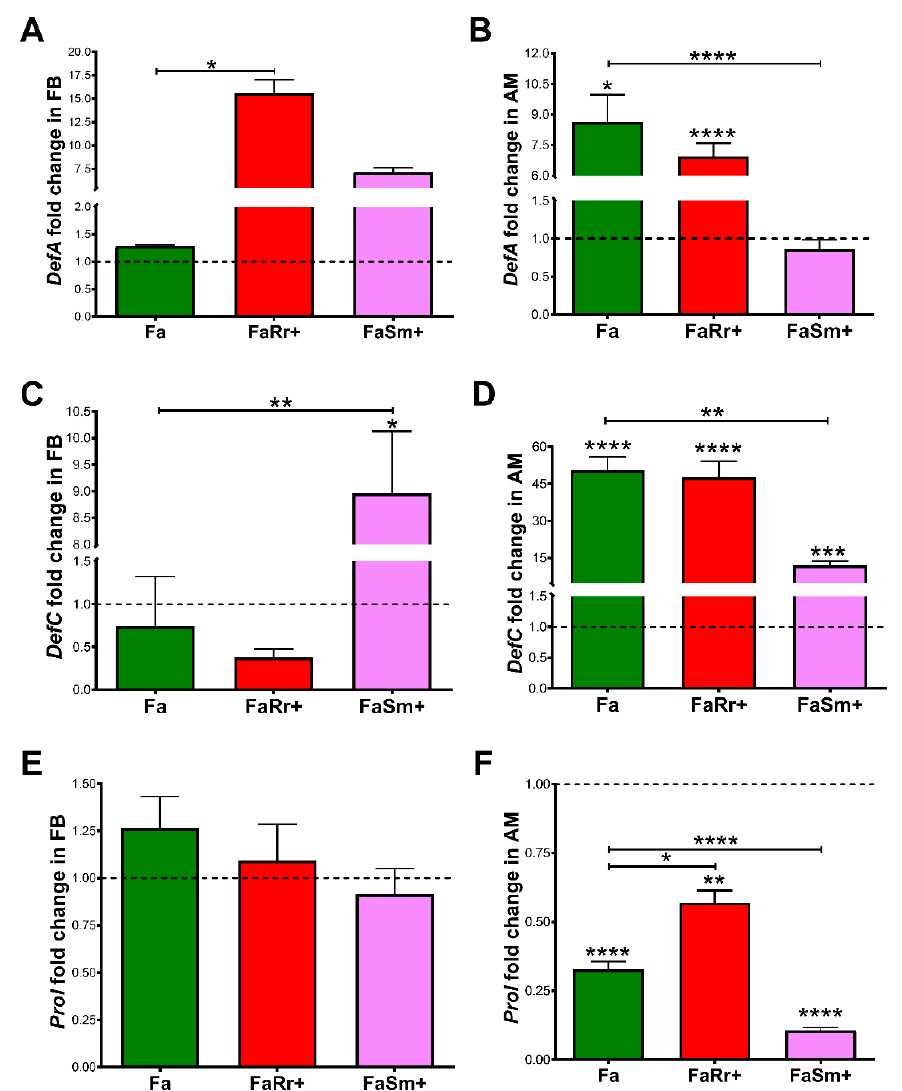
Figure 5. Antimicrobial peptide genes relative expression in the fat body (FB) and anterior midgut (AM) of Rhodnius prolixus 5th instar nymphs. The nymphs were previously fed with only antibiotic (Fa), R. rhodnii plus antibiotic (FaRr+), or S. marcescens plus antibiotic (FaSm+). Fat body (FB) and anterior midgut (AM) were collected 7 days after feeding. Relative expression of DefA ( A , B ), DefC ( C , D ), and Prol in ( E , F ) were analyzed in the fat body ( A , C , E ) and anterior midgut ( B , D , F ). Data were quantified using the gene expression of control insects as the calibrator. Bars represent the mean of 2 independent experiments—2 pools of 5 tissues each, with a total of 20 insects ( n = 4). ∆∆ Ct values were analyzed by one-way ANOVA compared with the post-hoc Tukey test, * p < 0.05; ** p < 0.01; *** p < 0.001; **** p <